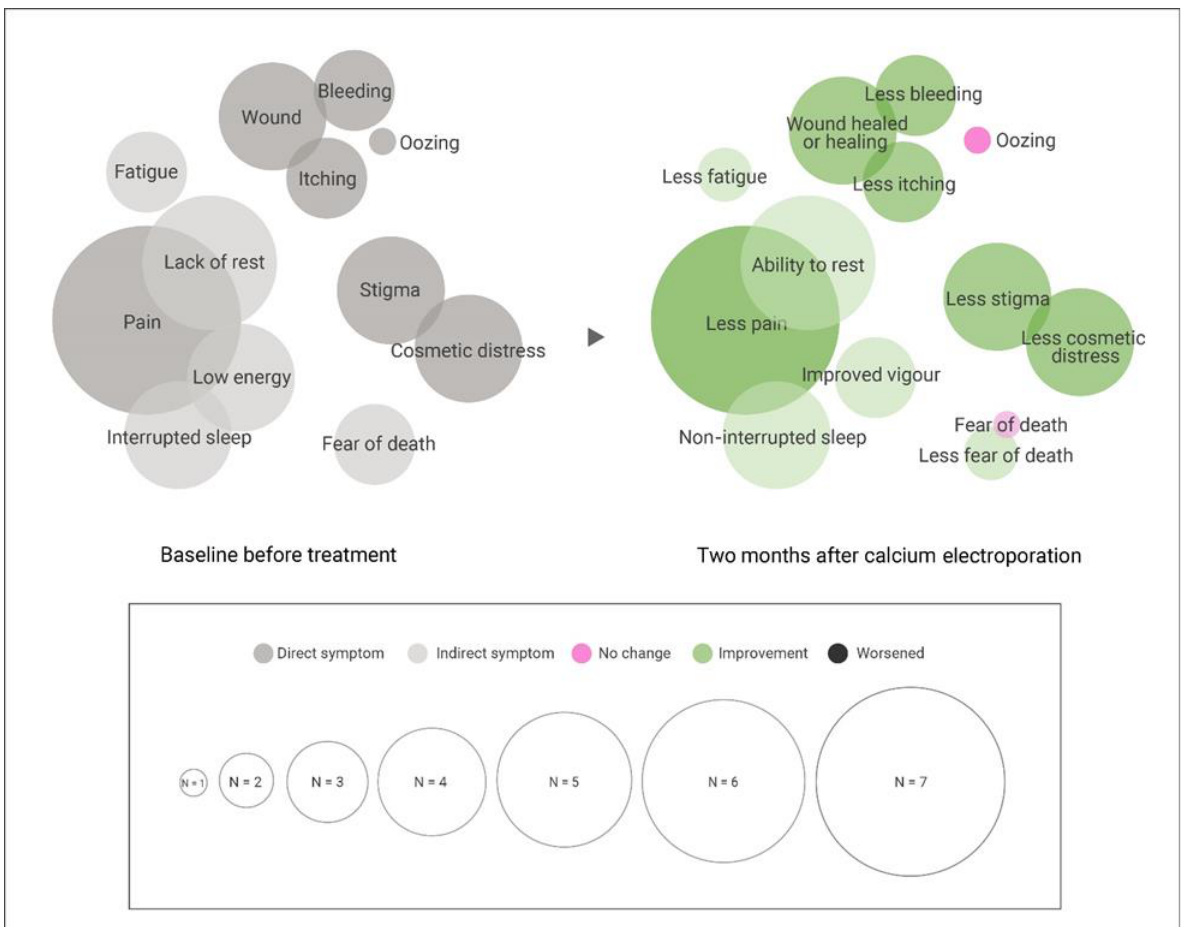
Figure 3. Patient-reported symptoms related to cutaneous metastases that affect quality of life before and two months after calcium electroporation. Bubble size is diameter relative to number of reporting patients from qualitative interview data, with the smallest bubble representing one report (n = 1) and largest seven reports (all, n = 7). Intense colour depicts direct symptoms from cutaneous metastasis, and low intensity depicts indirect symptoms. Green indicates improved symptoms. Note one patient reported no improvement in fear of death, and one patient reported unimproved oozing after two months (pink bubbles). The reporting patients of all other data points are the same before and after. One patient experienced transient improvement of fatigue, and one experienced transient improved vigour; These reports were not counted as improved or unchanged after two months. Apart from the two reports of unchanged symptoms and two re- ports of transient effects, there was unanimous improvement of direct and indirect symptoms related to cutaneous me- tastases.